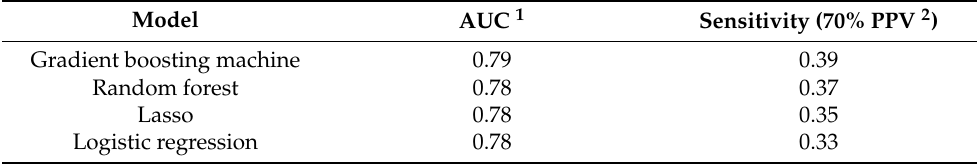
Table 1. Performance of the models for individual-centric discharge ranked by the AUC and PPV.